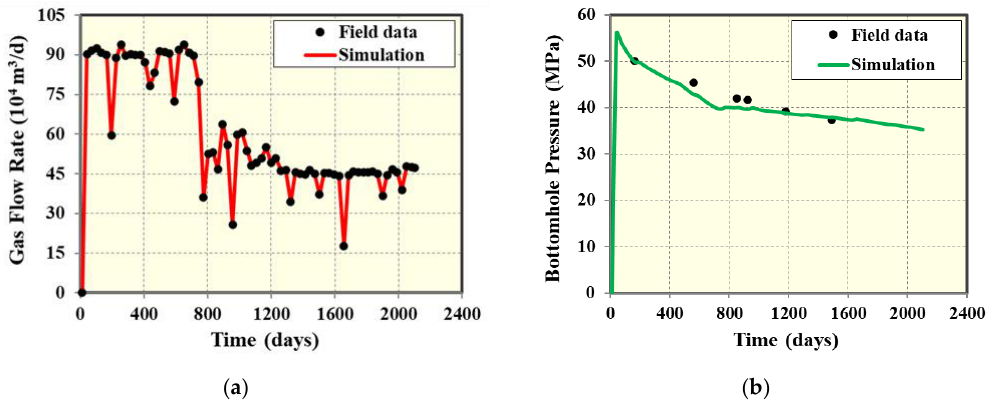
Figure 35. Single-well model simulation and history matching results of well B1. The points represent the field data while the solid lines represent the simulated values: ( a ) gas flow rate history matching results; ( b ) BHP history matching results.